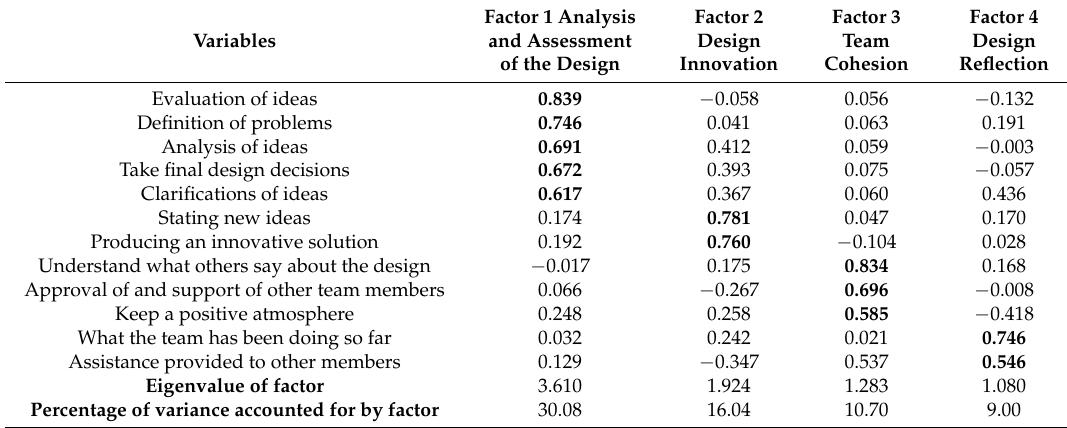
Table 4. The results of a factor analysis on the variables assessed by the students a . Variables